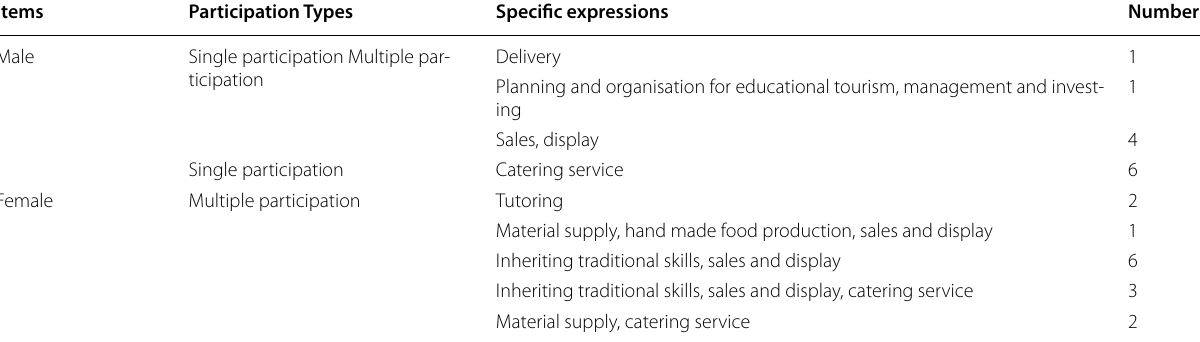
Table 3 Participation of residents in tourism in Digang Village Items